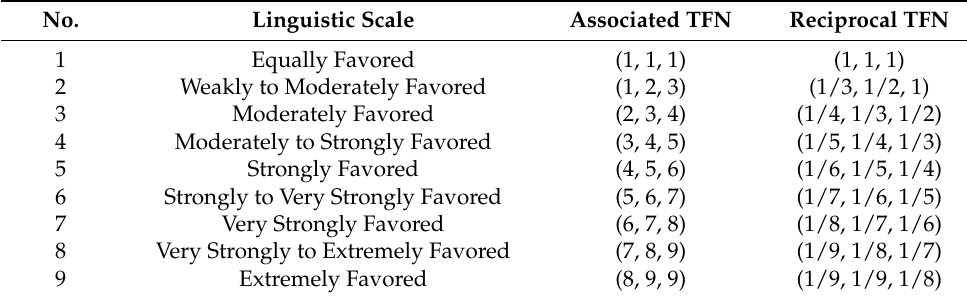
Table 2. Preferential Scale for TFN method to rank challenges [47]. No. Linguistic